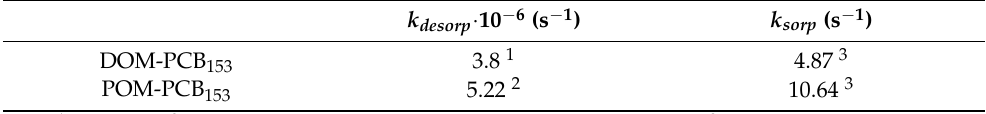
Table 2. Rate constants describing process of PCB 153 sorption on organic